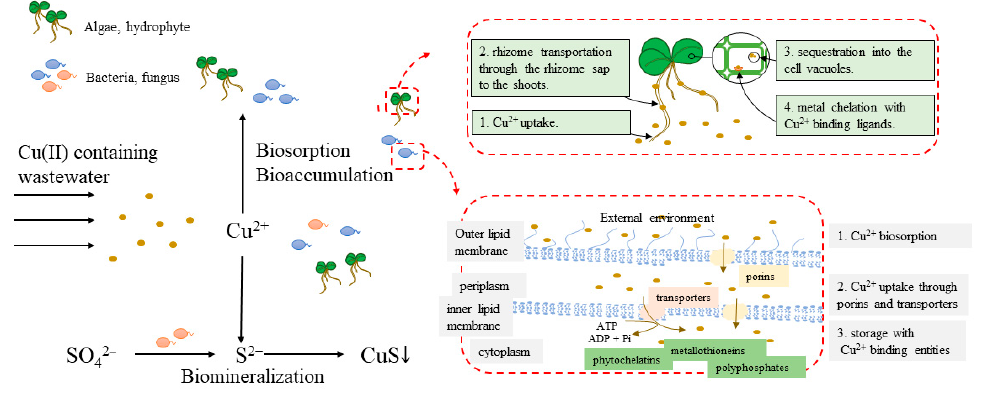
Figure 4. Biotechnology for copper